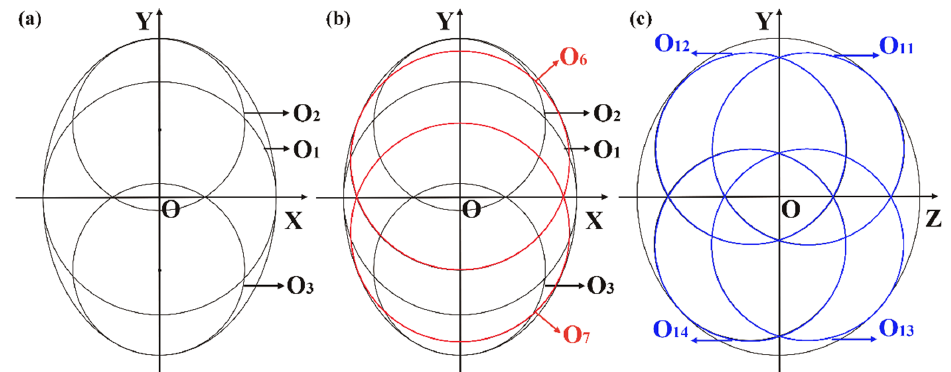
Figure 1. Triaxial sizes of one single soybean particle under the space rectangular coordinate sys- tem.